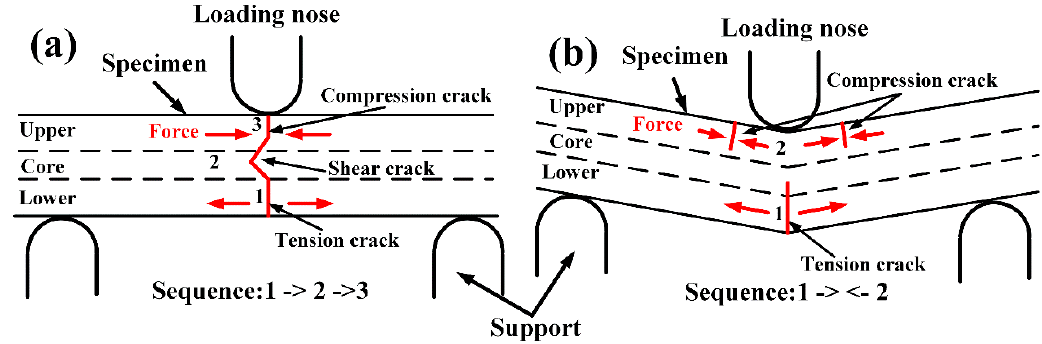
Figure 9. Schematic drawing of the fracture sequence of SCFR/PEEK composites at room temperature and high temperature: ( a ) specimen fracture at room temperature, ( b ) specimen fracture at high temperature, above T g .